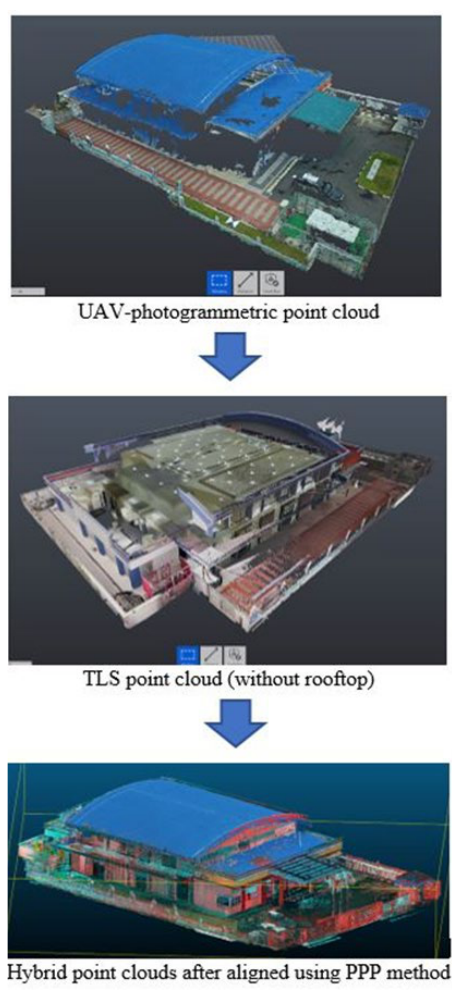
Figure 12. Hybrid point clouds formation